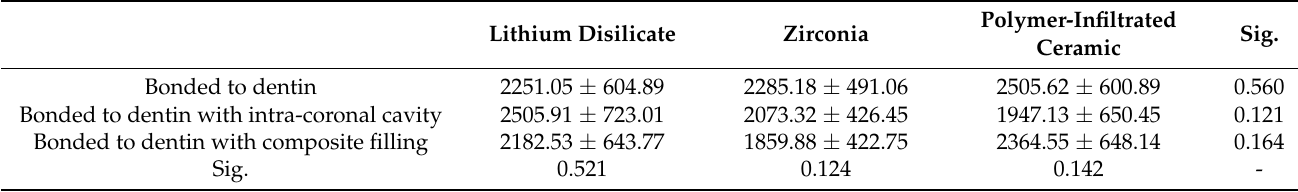
Table 3. Mean and standard deviation of fracture resistance values (N) of the studied groups.